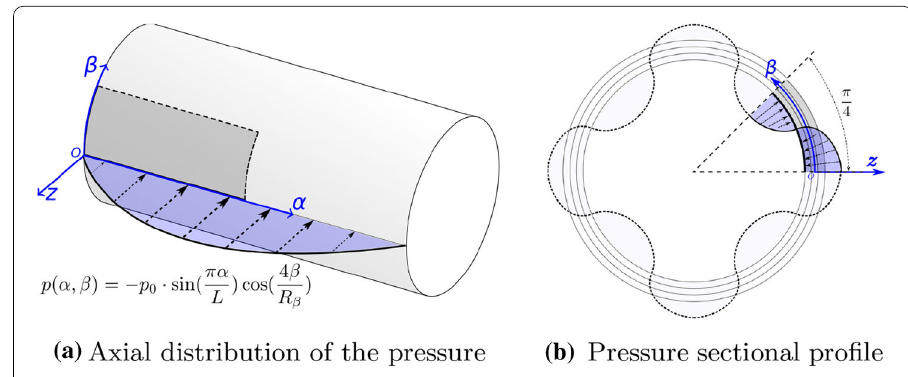
Fig. 7 The three-layered simply supported cylindrical shells under inner distributed pressure